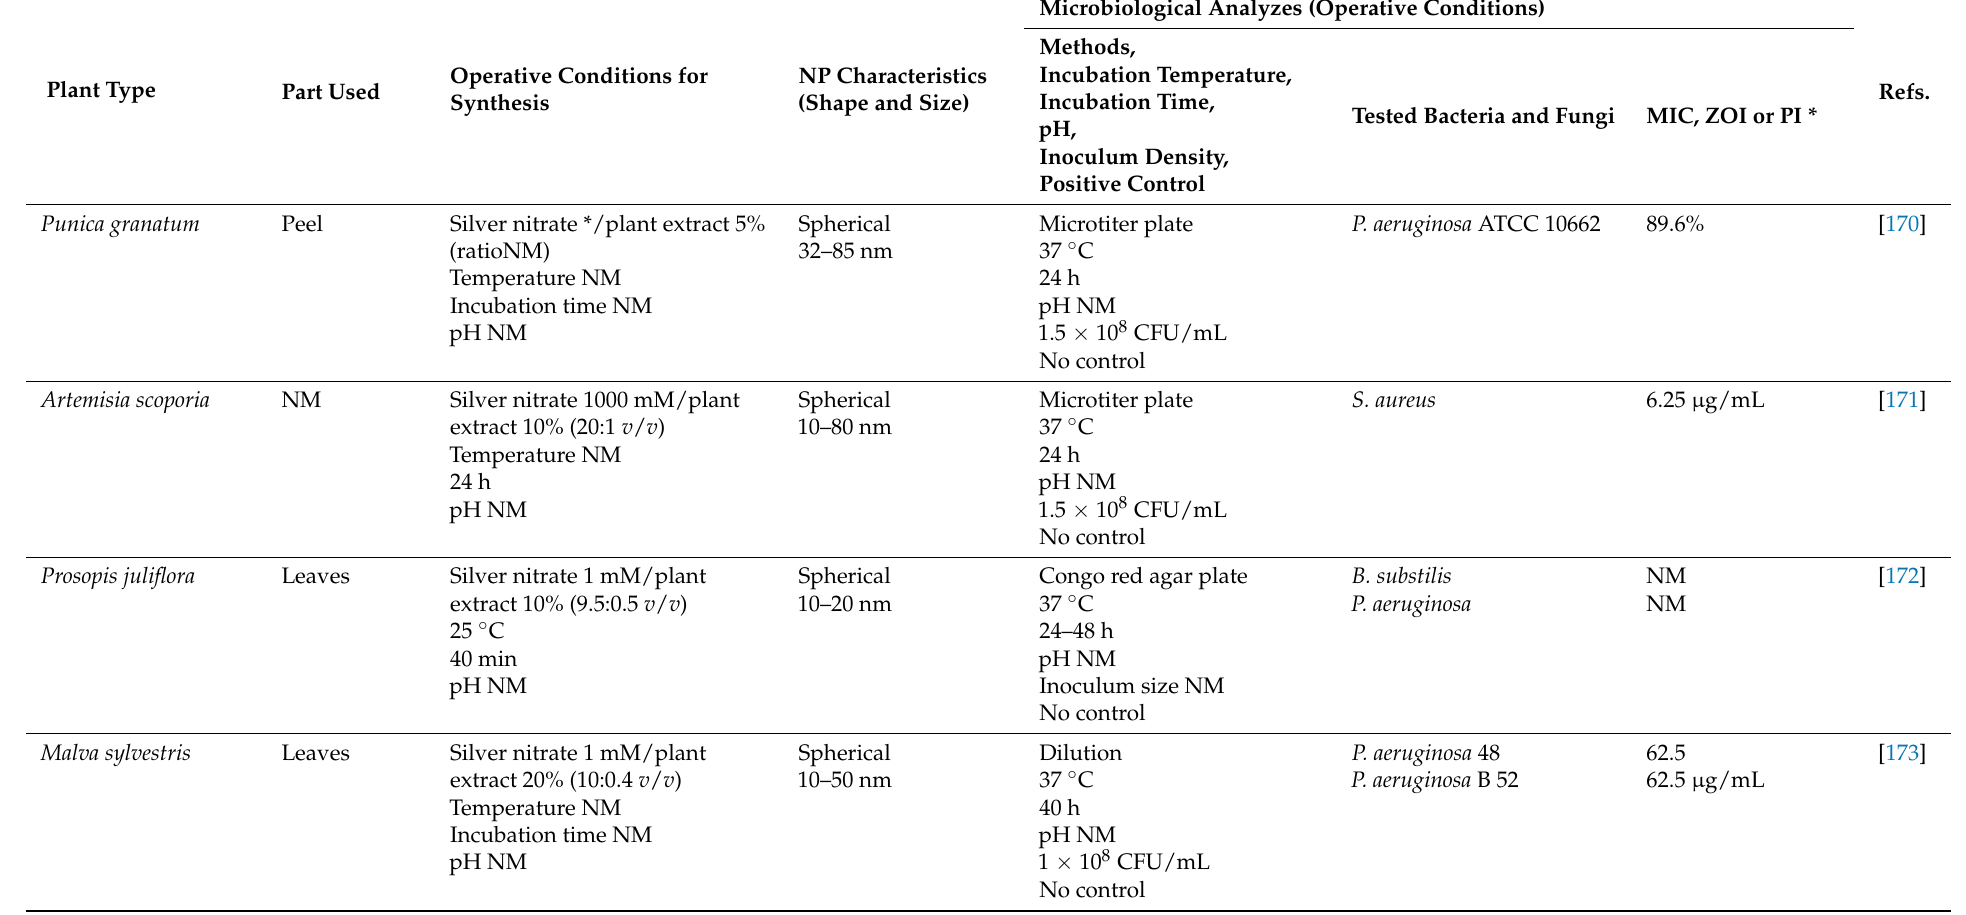
Table 2. Green silver nanoparticles with antibiofilm